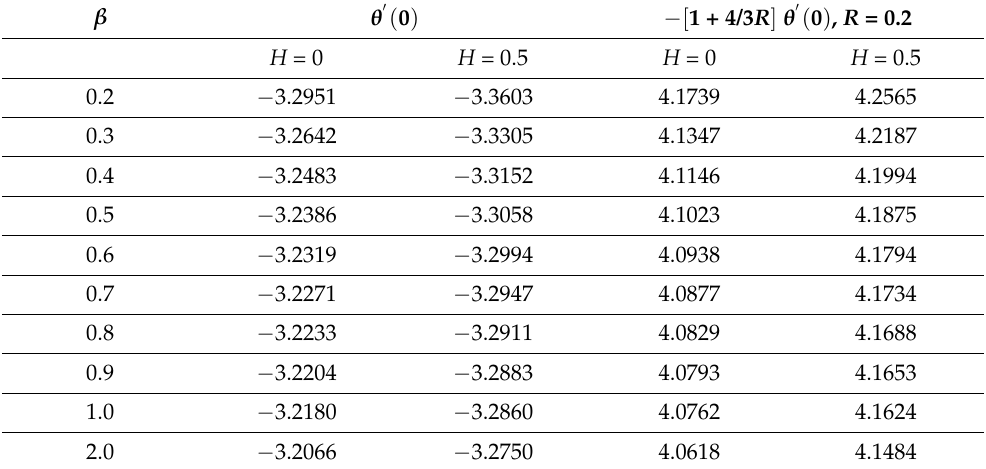
Table 16. Impact of Casson fluid parameter on Nusselt number with and without heat generation.